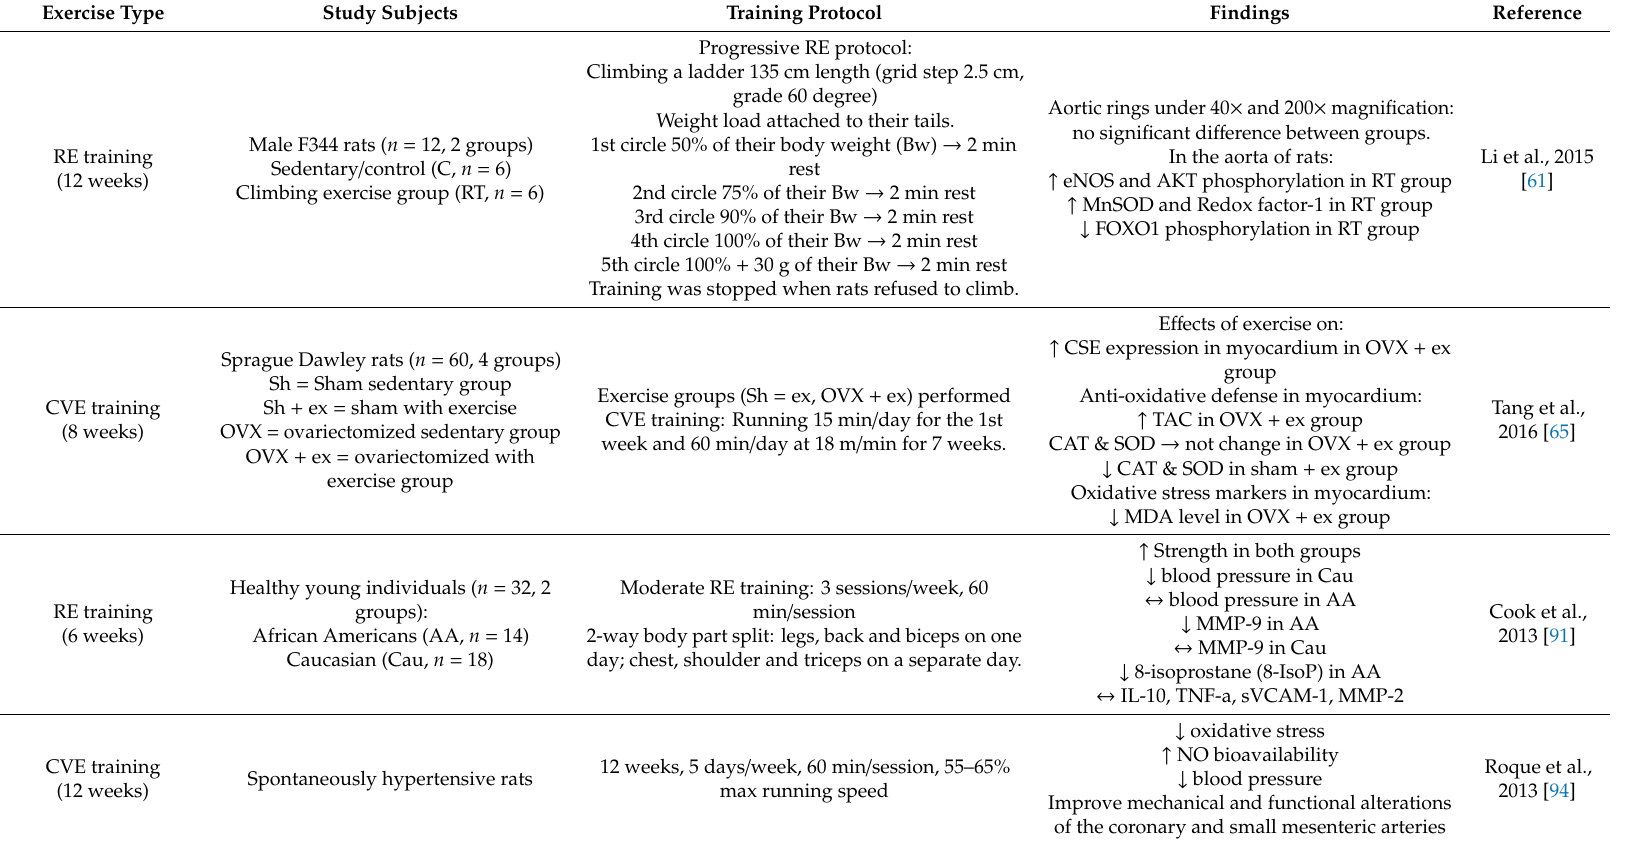
Table 2. E ff ects of Regular Exercise on Redox